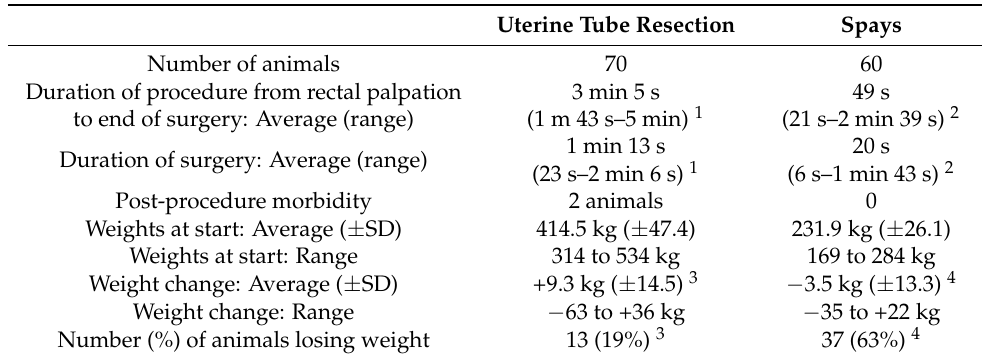
Table 1. Numbers of animals, procedure times, morbidity and weight of cows subjected to UTR and heifers spayed using the dropped ovary